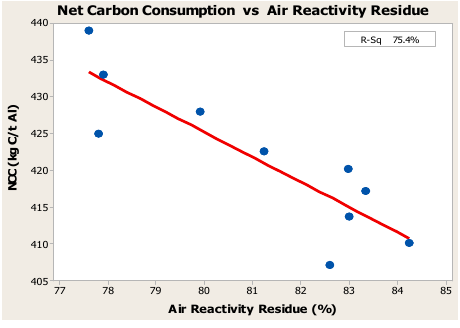
Figure 17. NCC vs. air RR.